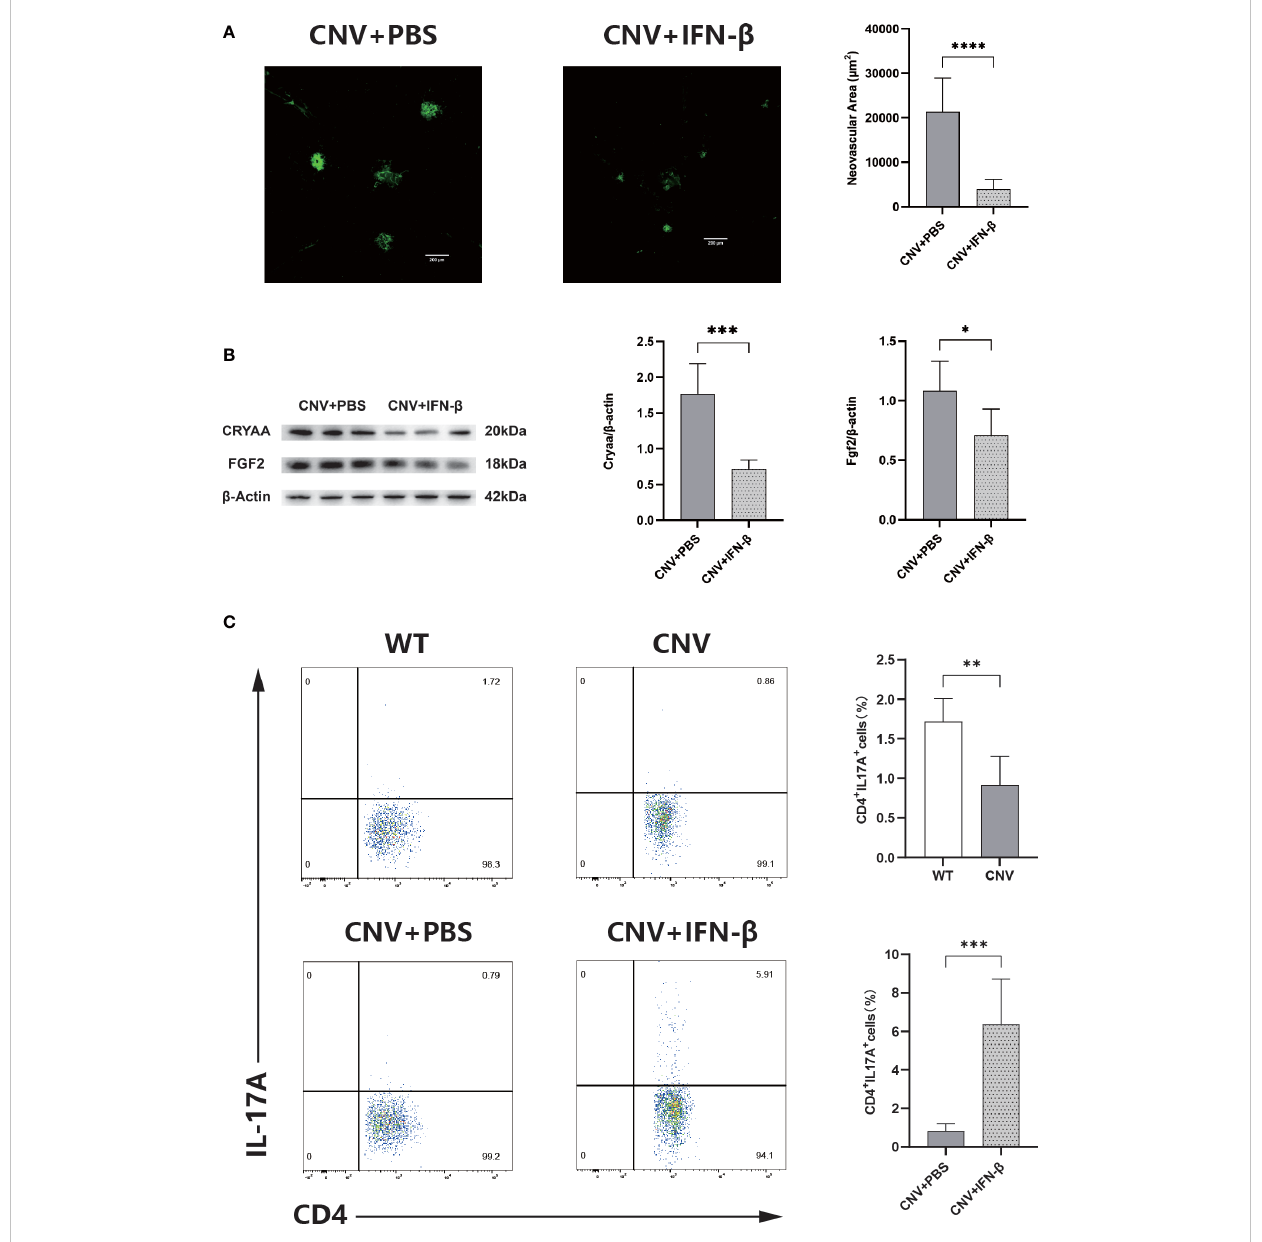
FIGURE 6 IFN- b therapy limits CNV. (A) Representative images of IB4-stained choroidal fl at mounts 7 days after laser coagulation in the PBS-treated (control) and IFN- b -treated groups. n = 6; mean ± SEM; Student ’ s t -test; **** p < 0.0001. (B) Western blot analysis of the expression levels of Cyraa and FGF2 in retinas in the PBS-treated and IFN- b -treated groups. n = 6; mean ± SD; Student ’ s t -test; * p < 0.05. (C) Representative fl ow charts of the proportion of Th17 cells from the retinas of wild-type (WT) and CNV groups, and the proportion of Th17 cells from the retinas of the PBS-treated and IFN- b -treated groups. n = 6; mean ± SD; Student ’ s t -test; ** p < 0.01, *** p < 0.001. CNV, choroidal neovascularization; IFN- b , interferon- b ; PBS, phosphate-buffered